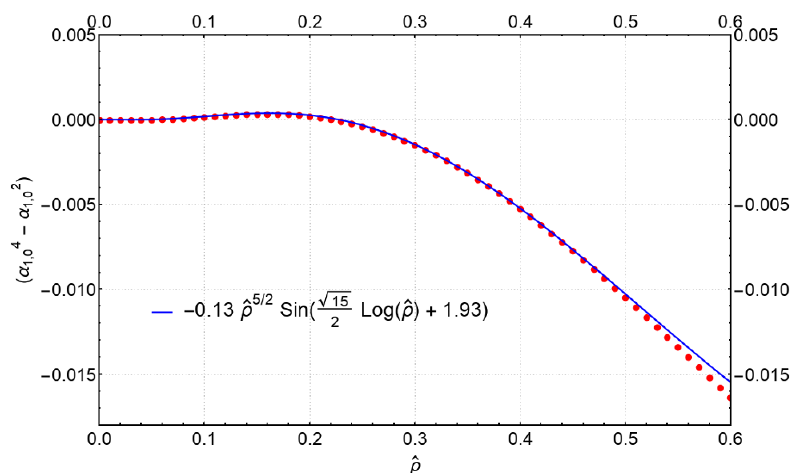
Figure 19 . A (cid:12)t of ^ (cid:11) 4